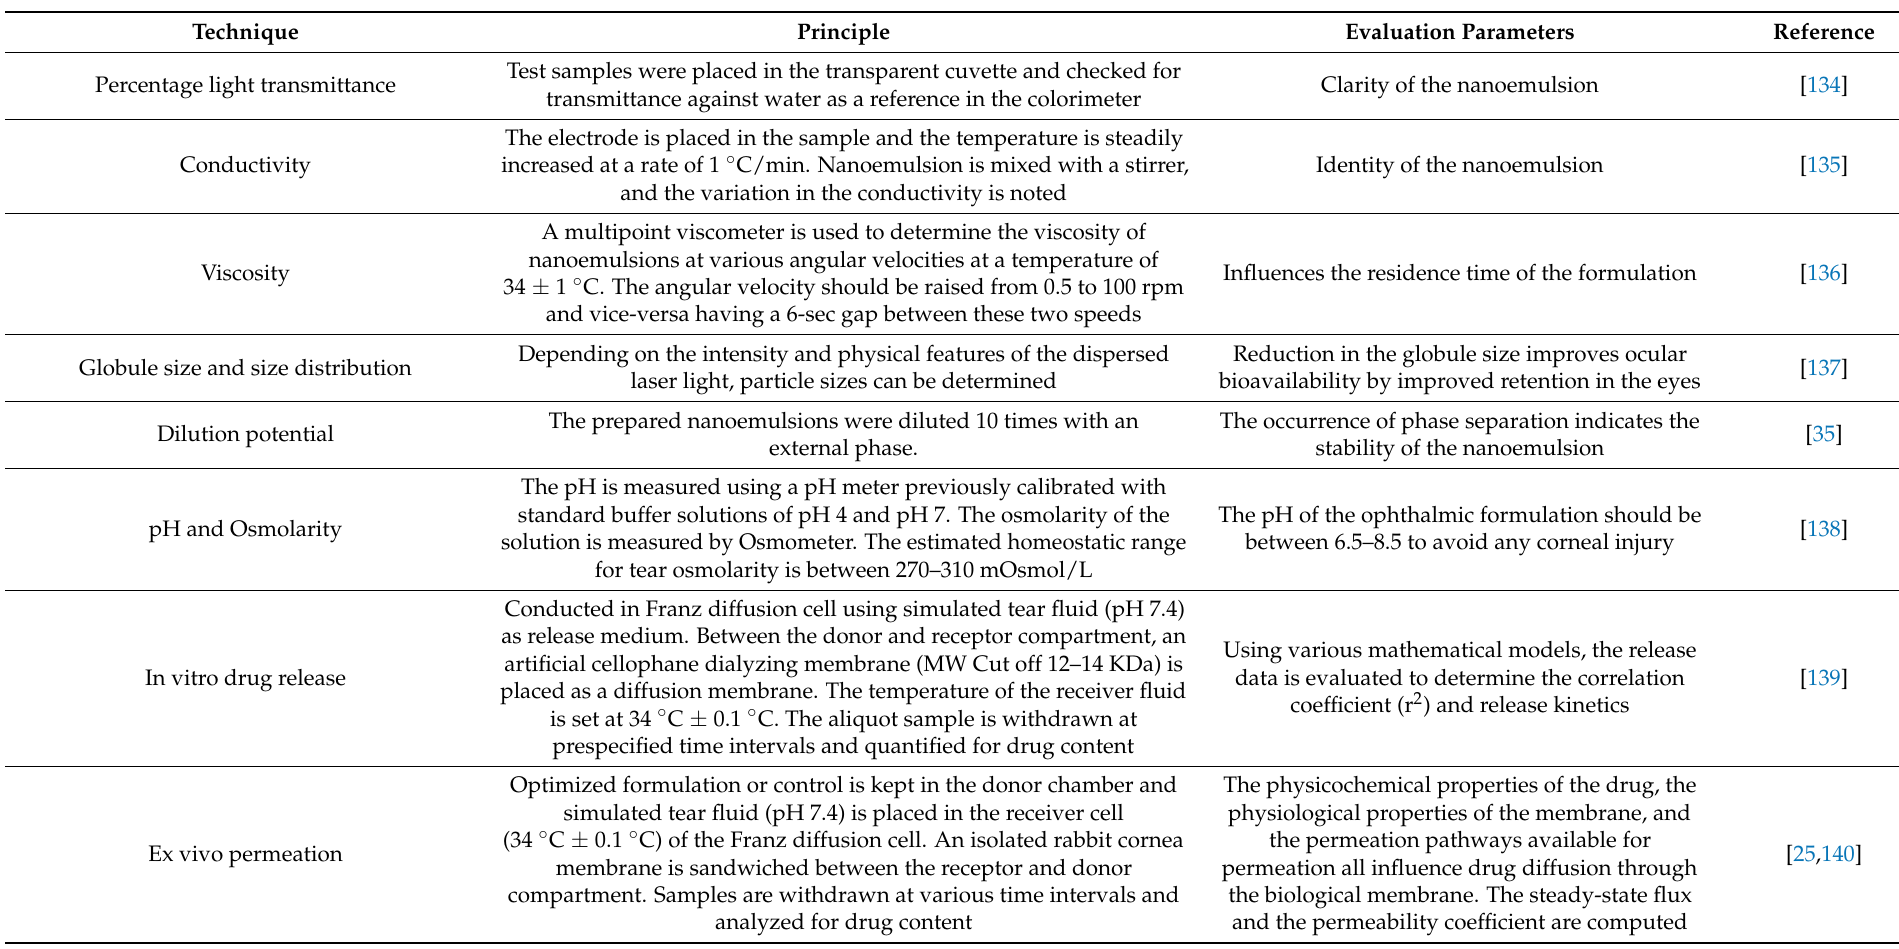
Table 5. Various characterization techniques typically utilized for nanoemulsions in ocular